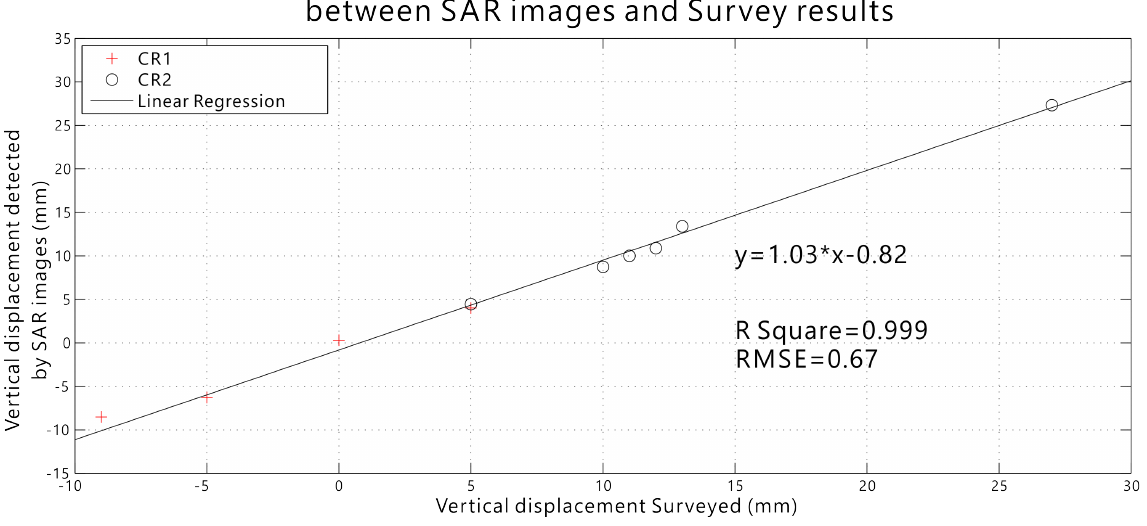
Figure 15. The statistical analyses on the deviation between the displacement detected by InSAR and by the leveling survey measurement when CR3 is taken as the reference